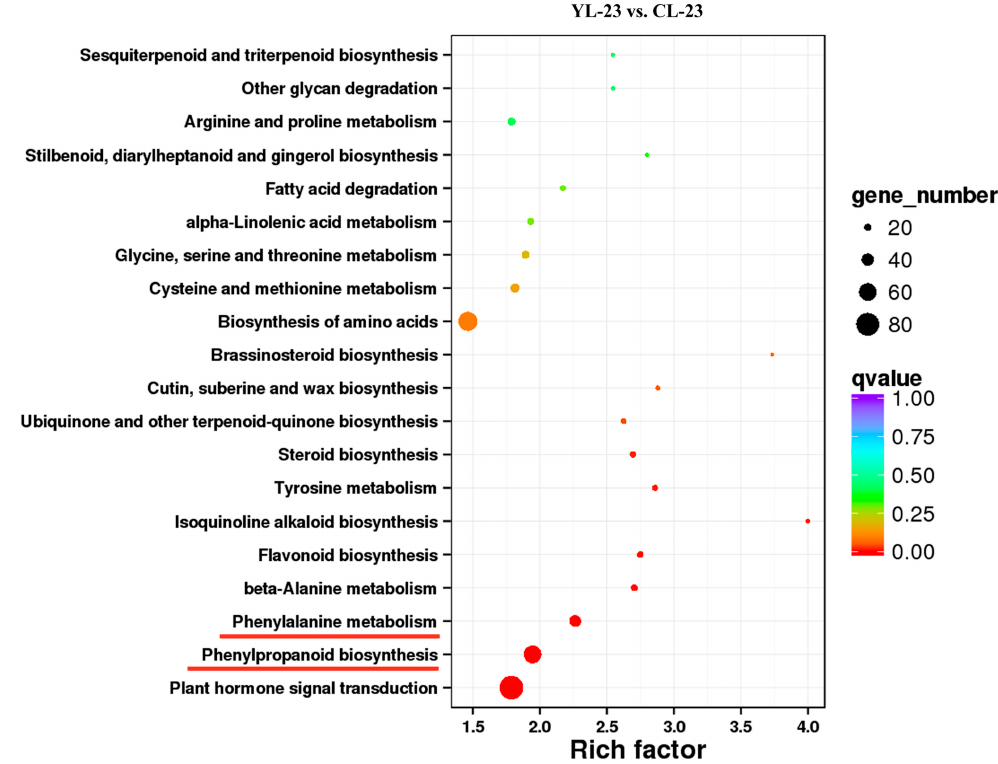
Figure 5. Kyoto Encyclopedia of Genes and Genomes (KEGG) classification maps